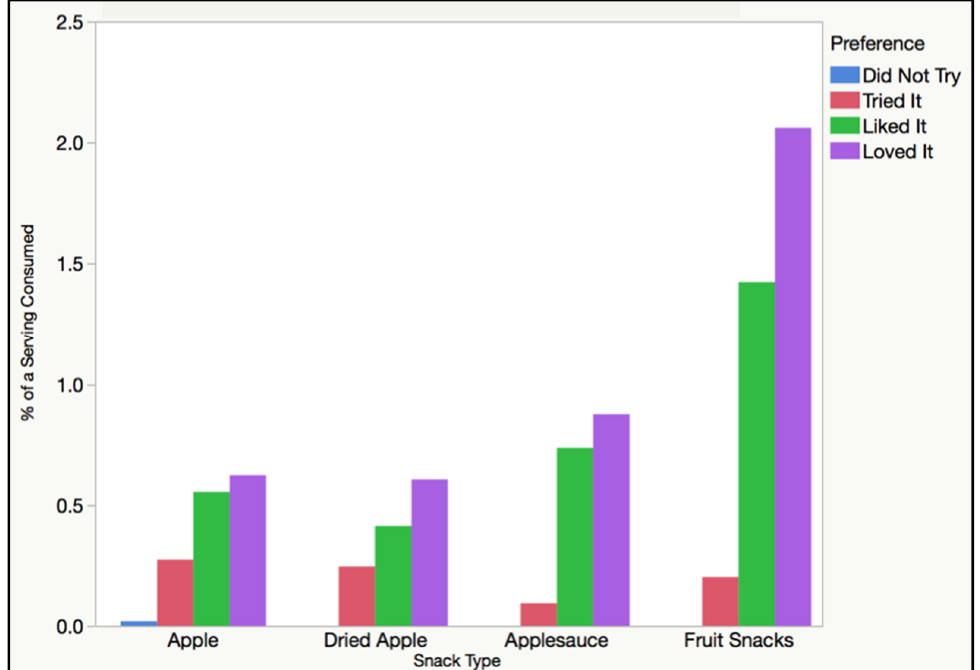
Figure 2. The percent of a serving consumed is detailed based on the four food processing levels and snack food options available to the students. It is important to note that since the selection had a linear relationship with consumption, the figure comparing selection to snack type was nearly the same as the one for consumption.